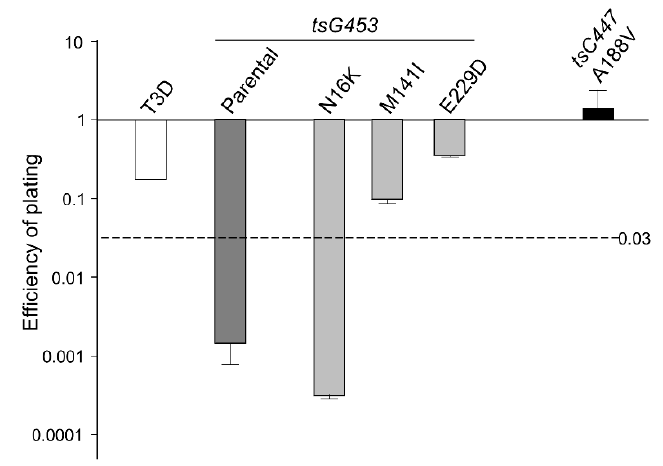
Figure 4. Efficiency of plating (EOP) of rescued virus isolates. EOP values were calculated by dividing the titer produced by the viruses shown at the restrictive incubation temperature of 39 ◦ C by the titer at the permissive temperature of 34.5 ◦ C. n = 3; Error bars = SEM.